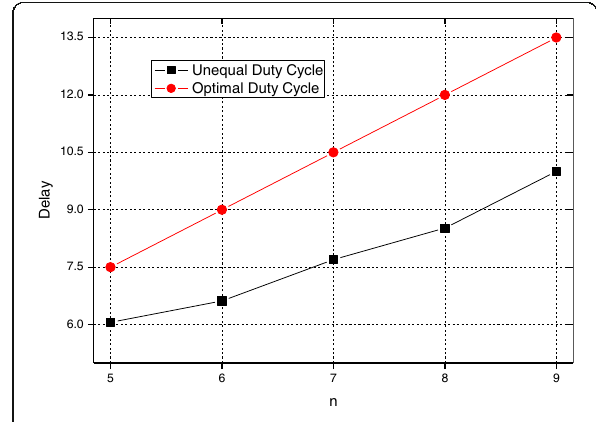
Fig. 23 The delay from each node in linear network to sink (MPSK)